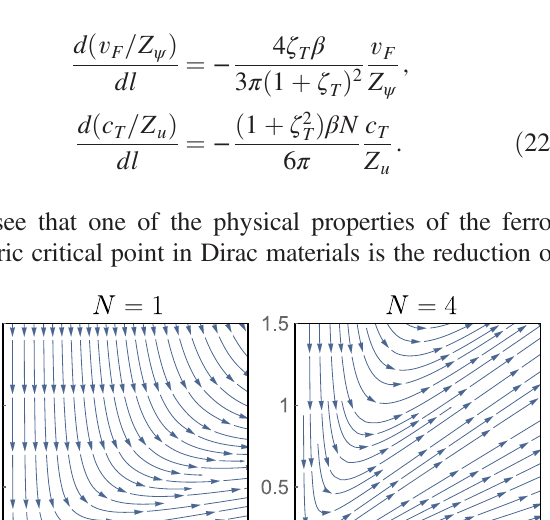
.FIG. 5. The phase diagram of a Dirac semimetal with N ¼ 4 close to a ferroelectric quantum critical point as a function of the bare values of the control parameter ˜ r 0 ¼ r 0 þ ð 5 γ 0 = 3 π 2 Þ − ð 2 N β 0 = 3 π Þ and the electron-phonon coupling β 0 . The red dashed line separates the two regions Λ r > Λ β and Λ r < Λ β , corre- sponding to weak- and strong-coupling regimes, respectively. In the former region, the finite mass of phonons cuts off the RG flow before β reaches strong coupling, and the theory with renorma- lized parameters remains weakly coupled. In the latter case, β flows to strong coupling before the system leaves the critical region. This regime is characterized by strong electron-phonon coupling and requires further study. The insets in each region schematically depict the dispersion close to the four L points. Every Dirac cone in the paraelectric phase splits into two Weyl points in the ferroelectric